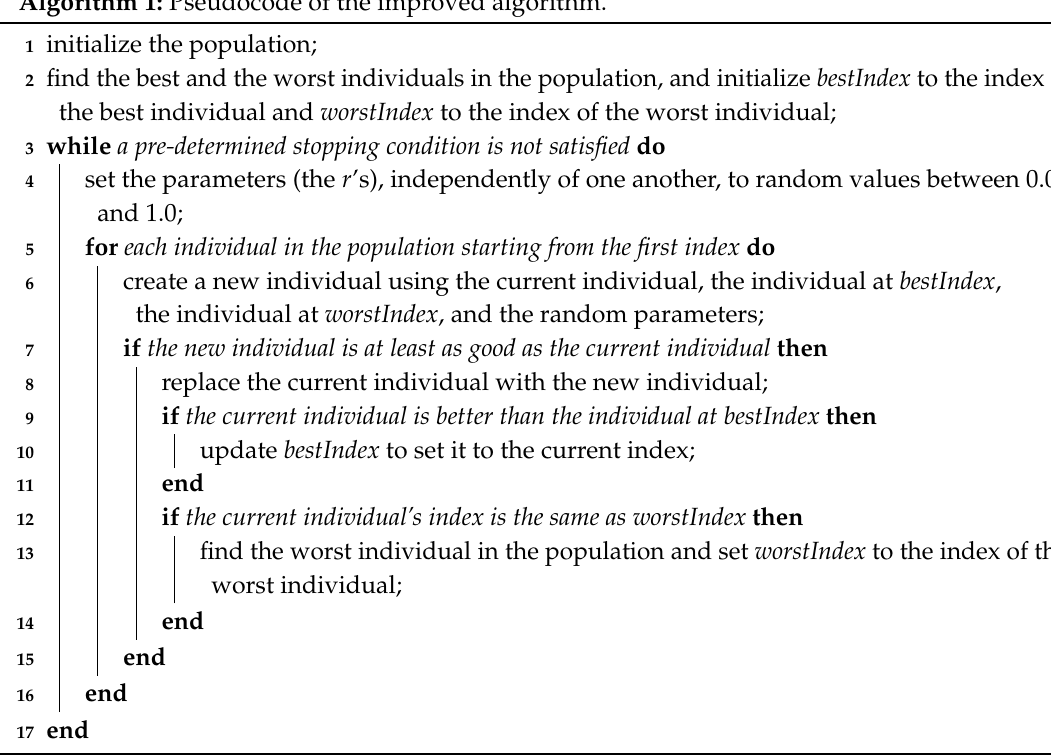
Algorithm 1: Pseudocode of the improved